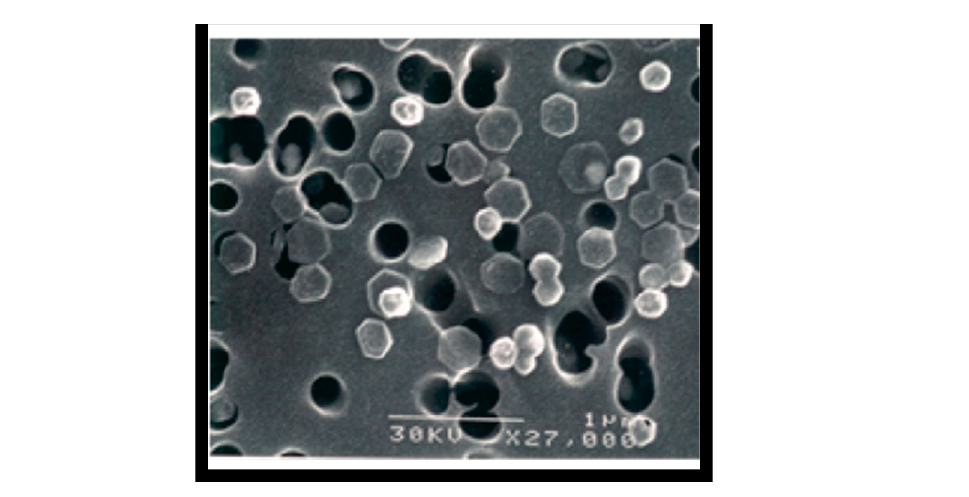
Figure 3. Hexagonal in shape silver platelets deposited on a polycarbonate membrane. They were obtained by reduction in the presence of an adsorbent. The bar size is 1.2 μ m long. Partly redrawn from Ref. [32].